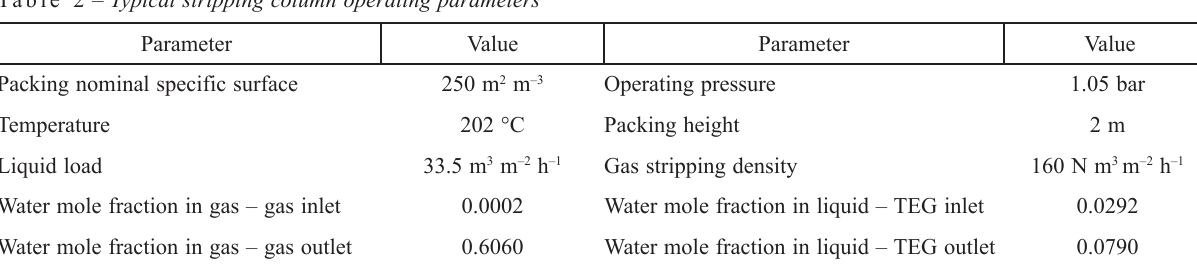
Table 2 – Typical stripping column operating parameters